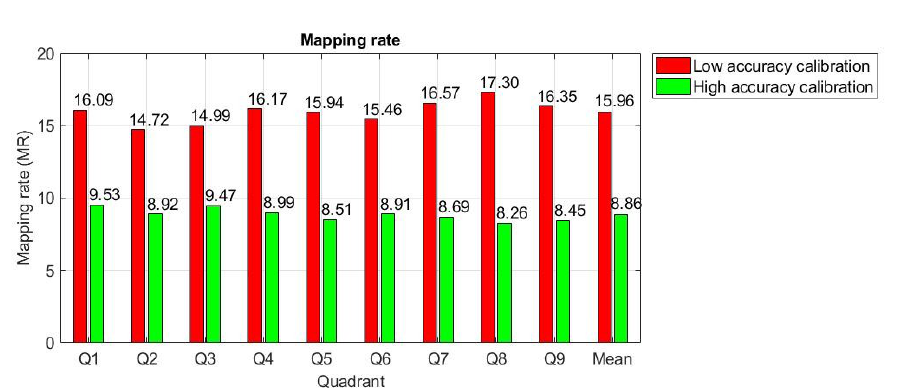
Figure 4. Mapping rate determination for low and high accuracies of the calibration procedure.